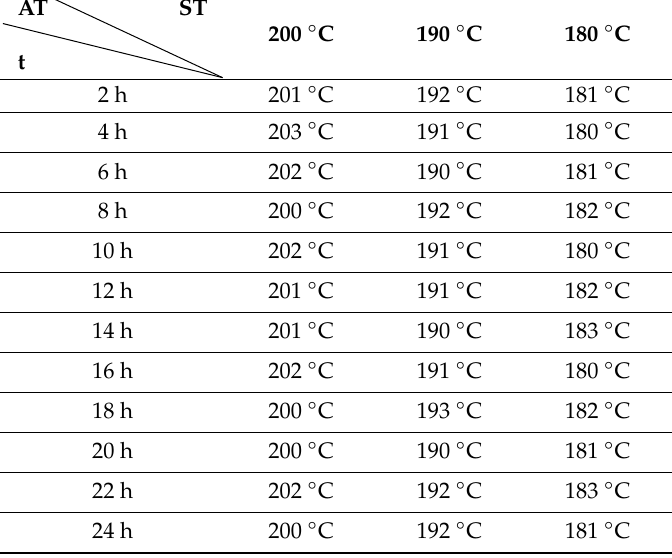
Table 5. The stability of di ff erent temperature of the oven was monitored during 24 h.